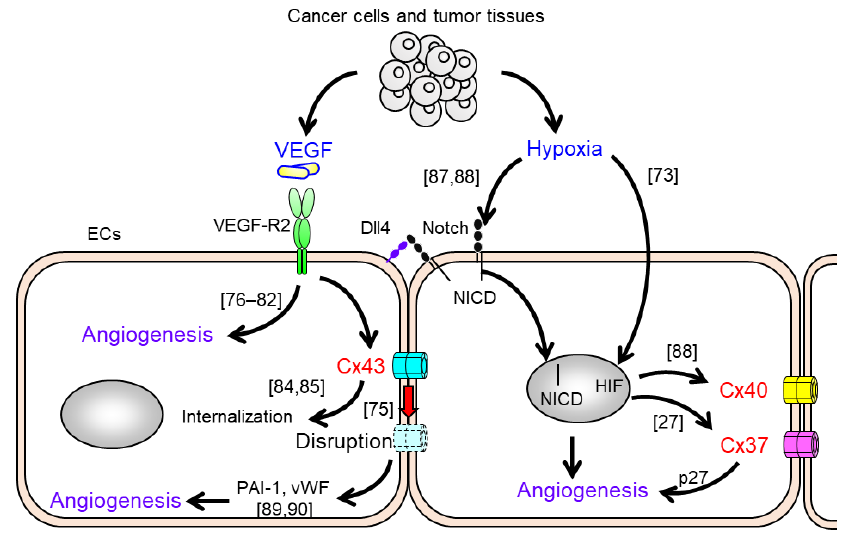
Figure 1. Alteration of gap junction function and Cx expression in endothelial cells (ECs) in response to pro-angiogenic stimuli. Vascular endothelial growth factor (VEGF), secreted by cancer cells, is an essential initiator of angiogenesis [82]. Endothelial cells induce internalization and disruption of gap junctions (GJs) formed by Cx43 under VEGF-VEGF-R2 signaling [75,84,85]. The impairment of Cx43 increases proangiogenic plasminogen activator inhibitor-1 (PAI-1) [89] and von Willebrand factor